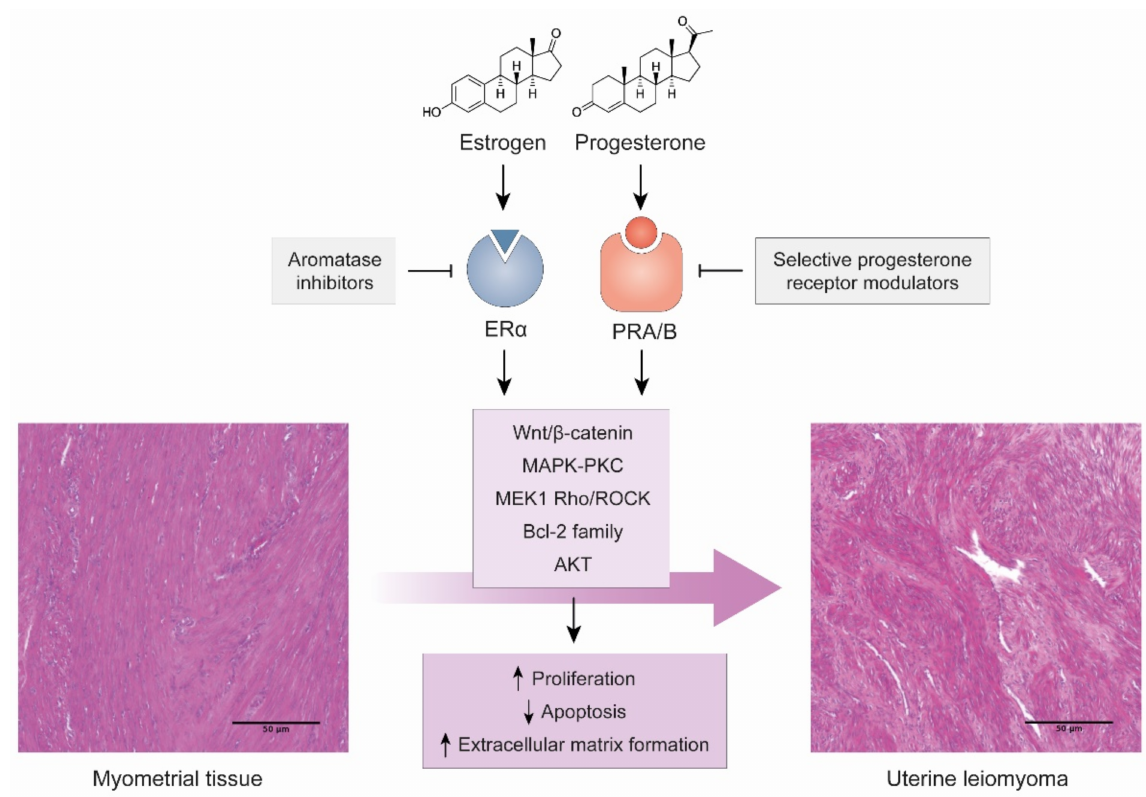
Figure 1. Hormonal action on myometrial tissue as a cause of uLM. Images of H&E-stained tissues from our group’s archives. Scale bars represent 100 µ